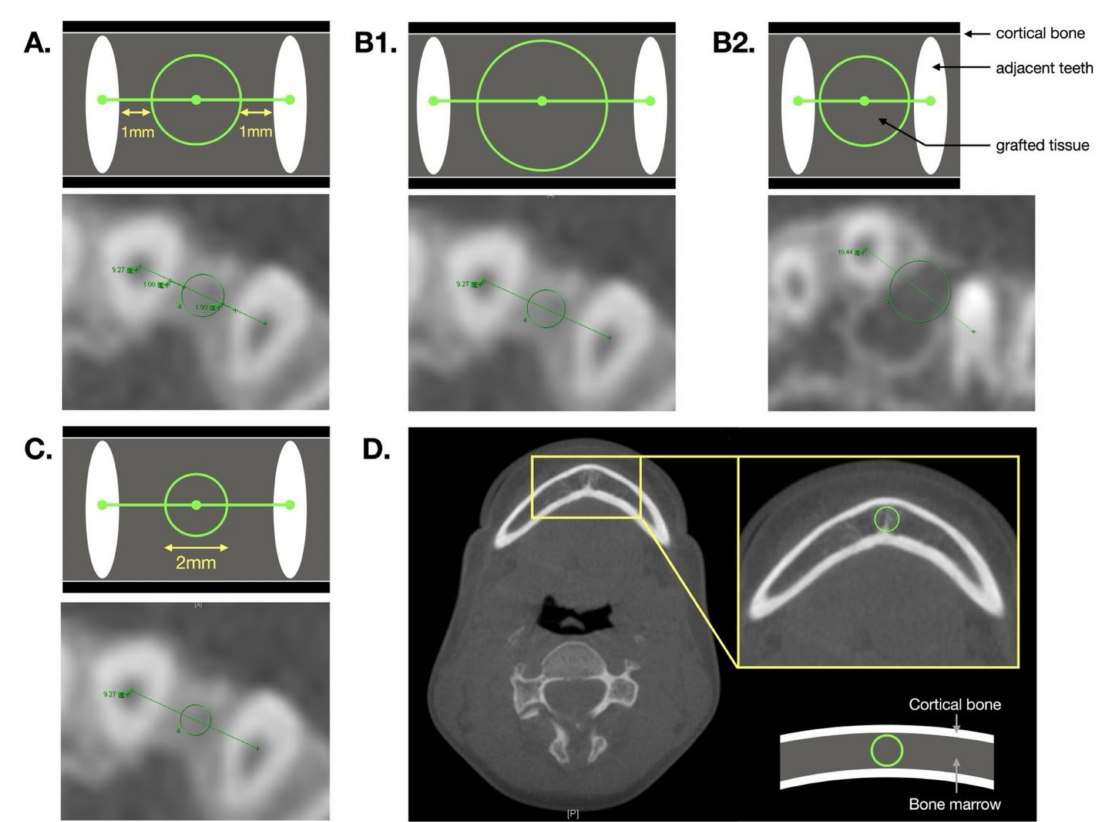
Figure 2. Axial image of grafted area with schemes. ( A ) For Method A, a circle located 1 mm from the adjacent teeth is sketched. For Method B, the largest circular area of grafted tissue is sketched. Two possible conditions apply for Method B. ( B1 ) If the distance between two adjacent teeth is greater than the thickness of the alveolar defect, a circle tangent to surrounding cortical bone density is drawn. ( B2 ) If the distance between two adjacent teeth is less than the thickness of the alveolar defect, a circle transecting the two adjacent teeth is selected. ( C ) For Method C, a central circle with a diameter of 2 mm is drawn. Note that ( A ), ( B1 ), and ( C ) are images of the same patient. ( D ) The largest circular zone within the pogonion bone marrow is used to obtain the pogonion density for